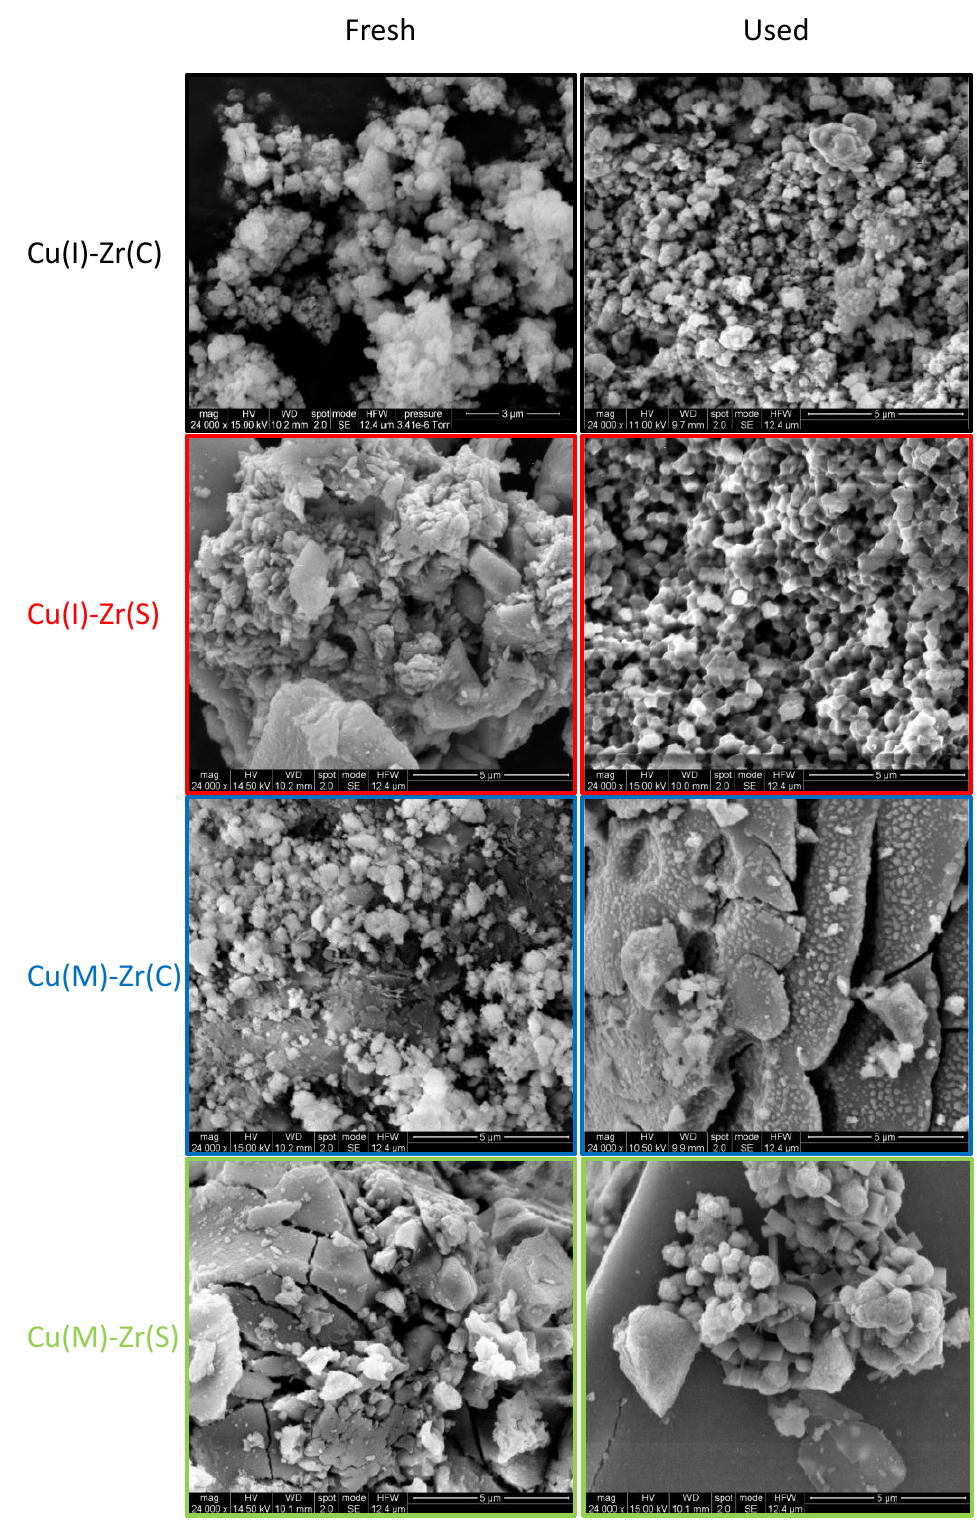
Figure 2. SEM images of both fresh and used samples.